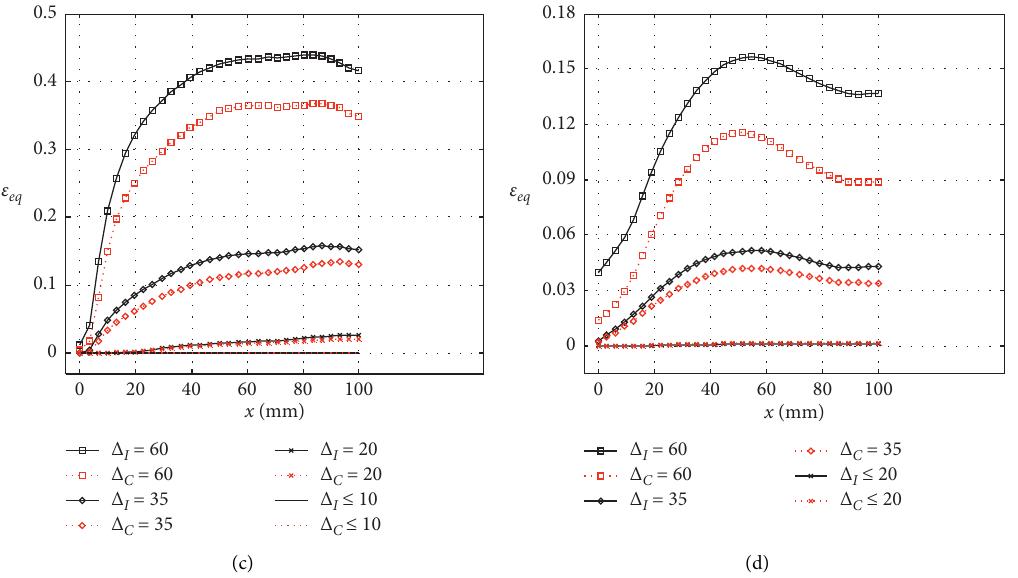
Figure 13: Equivalent strain ε ep at paths l 1 , l 2 , l 3 , and l 4 . (a) Path l 1 . (b) Path l 2 , (c) Path l 3 , (d) Path l 4 . The values without the unit in the legends indicate the displacement; ε ep is the value when the displacement at the loading point Δ first reached d represents the IHM-S result and Δ represents the CHM-S result. C